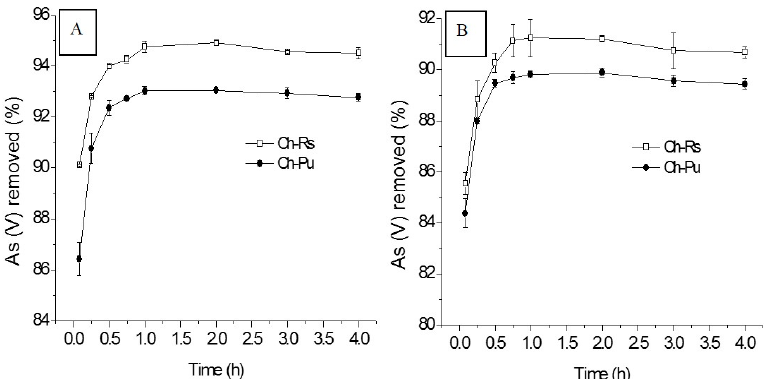
Figure 4. Effect of contact time on removal of As(V) by Ch–Rs and Ch–Pu blends at initial As (V) concentration of ( A ) 0.25 mg/L and ( B ) 2.0 mg/L (adsorbent dose 8 g/L, initial pH 7, shaking at 200 rpm at 24 ± 1 °C).